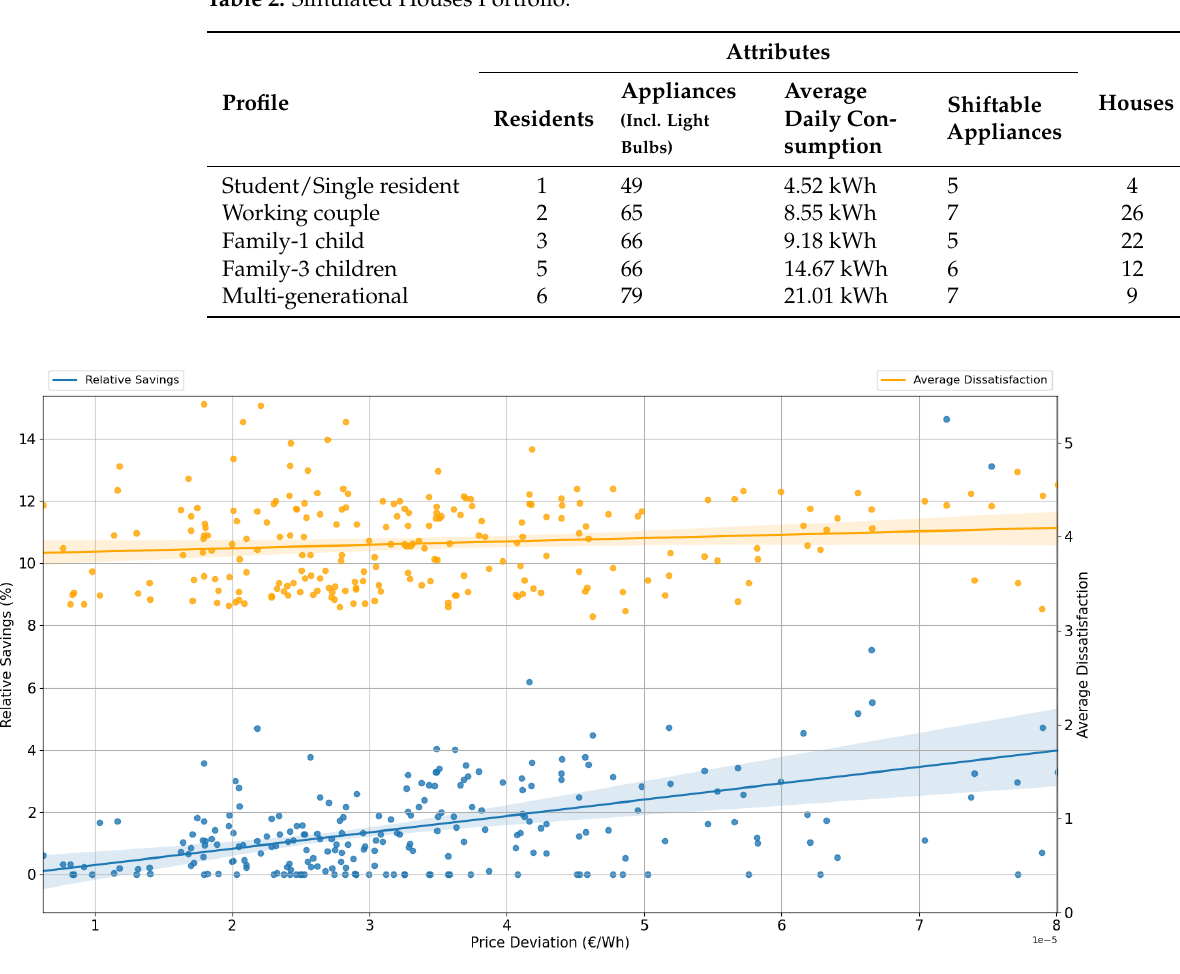
Figure 6. Correlation between price fluctuations and relative savings/average user dissatisfaction. Over the simulated nine-month period, the mean daily relative profit is equal to 1.48%, with a 3.45% variance. The 0.5-Quantile (0.5Q), that is, the median of the observations, is equal to 1.14%, which is lower than the mean value, a fact that indicates that the trend is to usually achieve daily profits of less that 1.48%. The 0.75-Quantile (0.75Q) is equal to 2.19%, meaning that 25% of the observations are characterised as a considerable profit margin. The 0.25-Quantile (0.25Q) is equal to 0.3%, which in fact can be attributed as an alarming factor, since the same amount of observations (25%) can have a